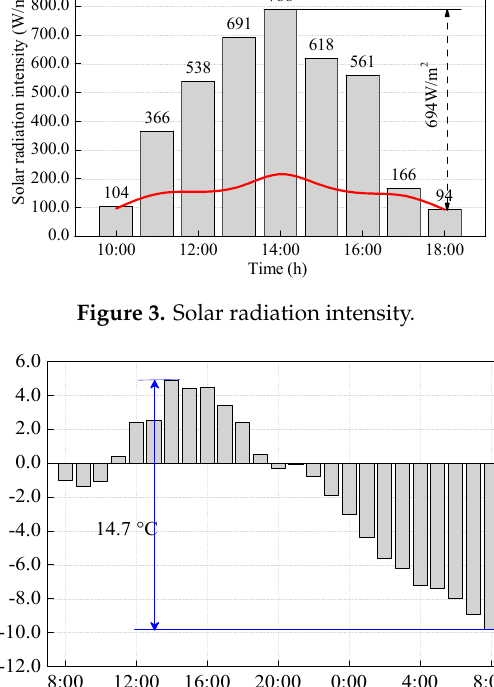
Figure 4. Outdoor air temperature.